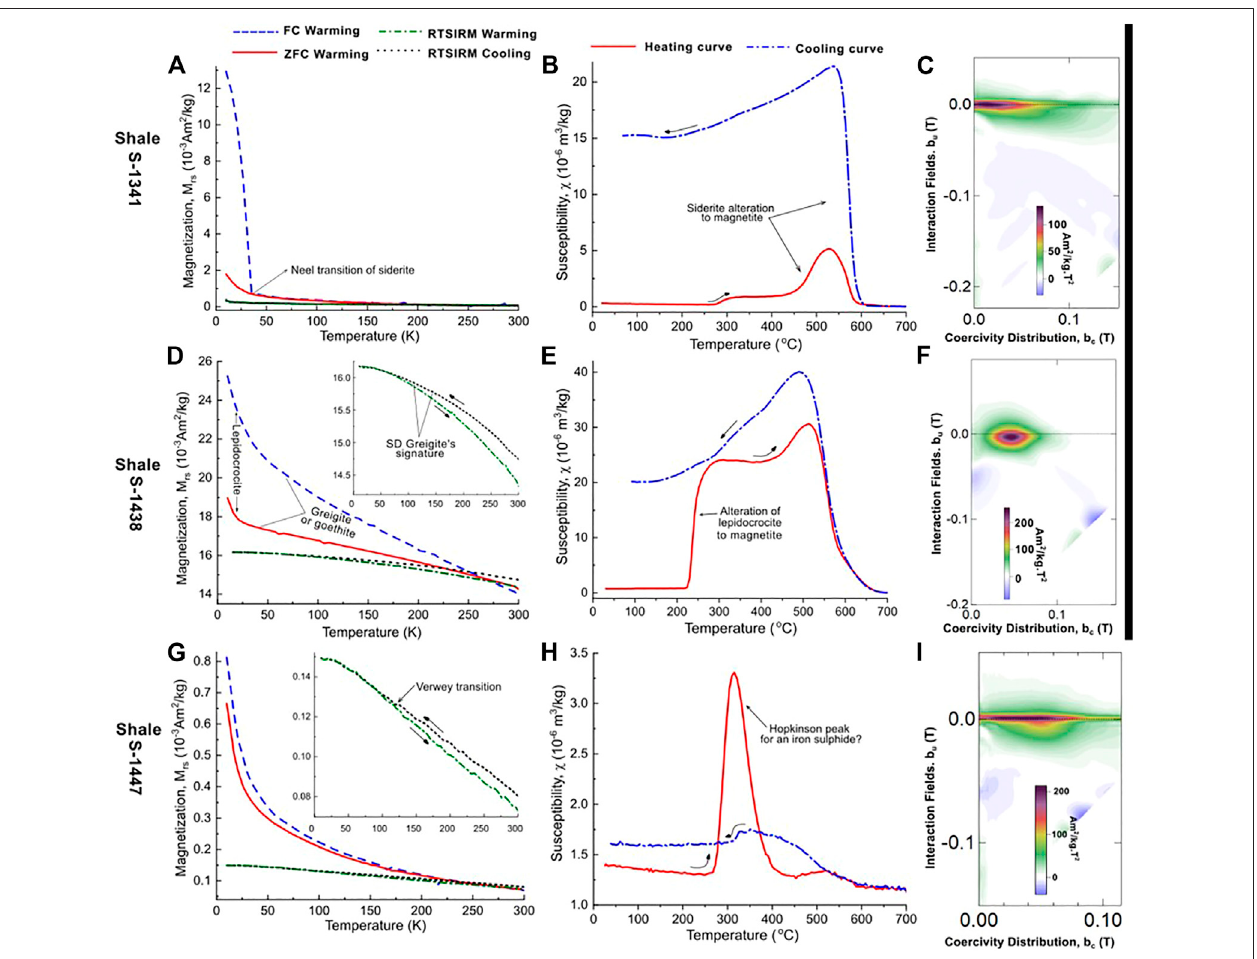
FIGURE 9 | Example results from LTM and HT- χ and FORC measurements for the shale samples; S-1341, S-1438 and S-1447 are shown on (A – C) , (D – F) , and (G – I) respectively. Theshalesamplesmeasurement curves suggestthepresence ofmagnetite, titanomagnetite(or theiroxidized versions), greigite, other paramagnetic iron-sulphides, lepidocrocite and potentially titanohematite and